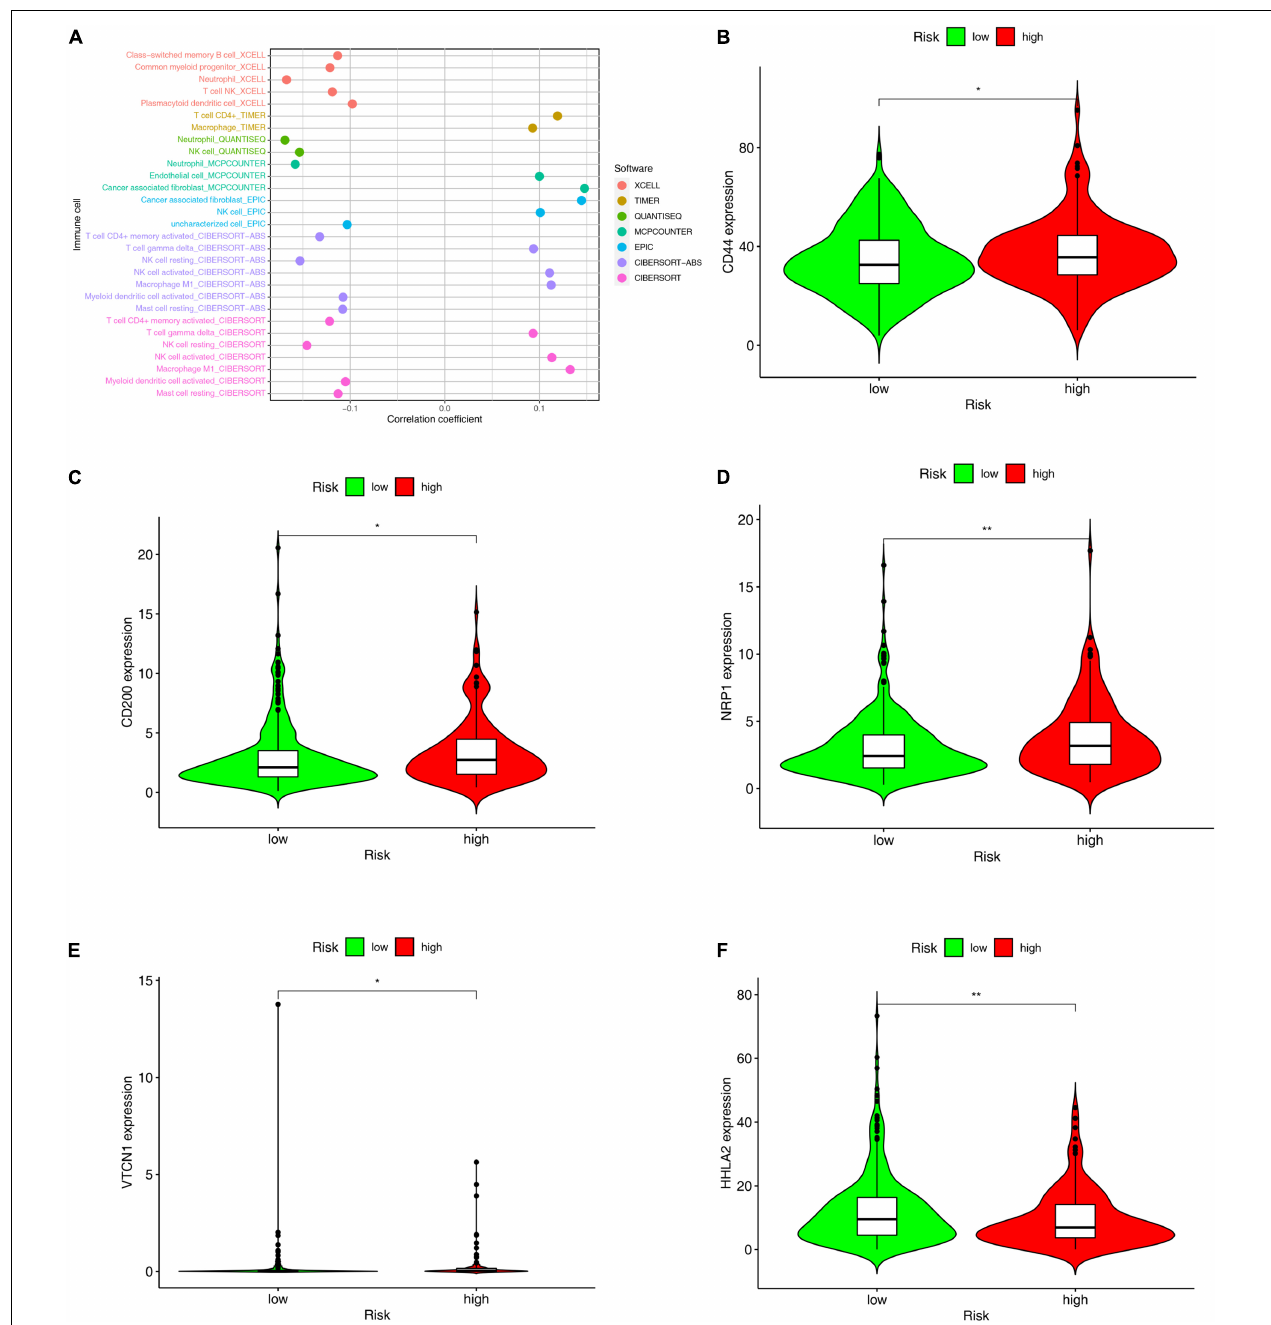
FIGURE 7 | Evaluation of tumor-infiltrating immune cells (TIICs) and molecules related to immune checkpoint through the constructed model. (A) The Spearman correlation analysis was conducted to examine the relationship between the TIICs and the constructed model. The patients with high-risk scores in the constructed model were more positively associated with TIICs, like cancer associated fibroblast, T cell gamma delta, activated NK cell, and Macrophage M1, but negatively associated with Neutrophil, T cell CD4+ memory, NK cell resting, myeloid dendritic cells, and mast cells. (B–F) The expression level of molecules related to Immune Checkpoint such as (B) CD44, (C) CD200, (D) NRP1 were higher in the individuals with high-risk scores than those with low-risk scores, whereas the expression level of (F) HHLA2 was higher in the individuals with low-risk scores.* p < 0.05; ** p <